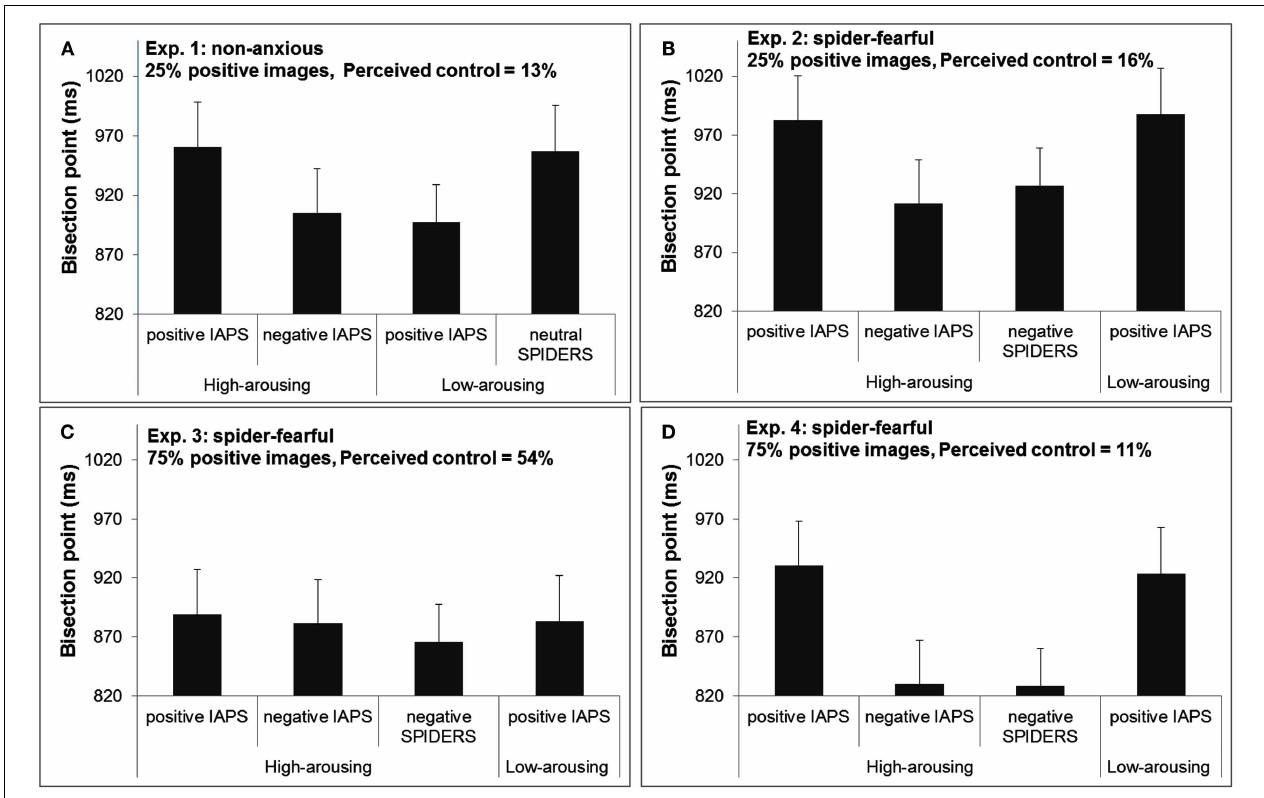
FIGURE 2 | Bisection points in Experiments 1–4 [(A–D), respectively], as a function of emotional content of image events. Note that when comparing two bisection points, the smaller bisection point